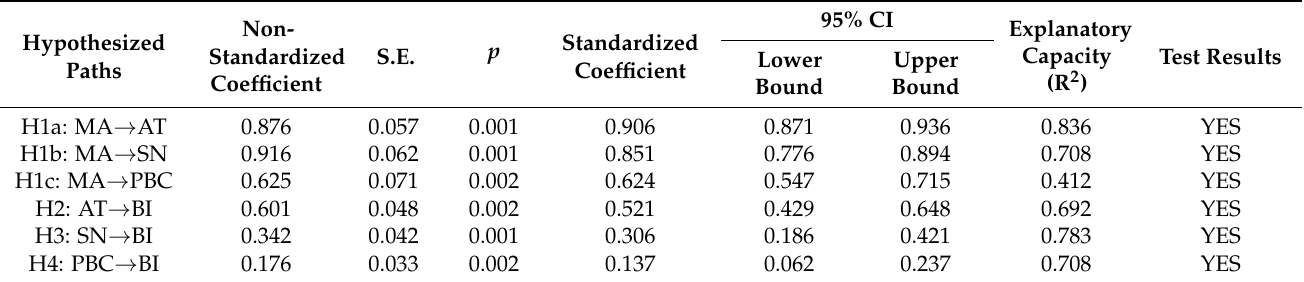
Table 3. Results of the path analysis and hypothesis